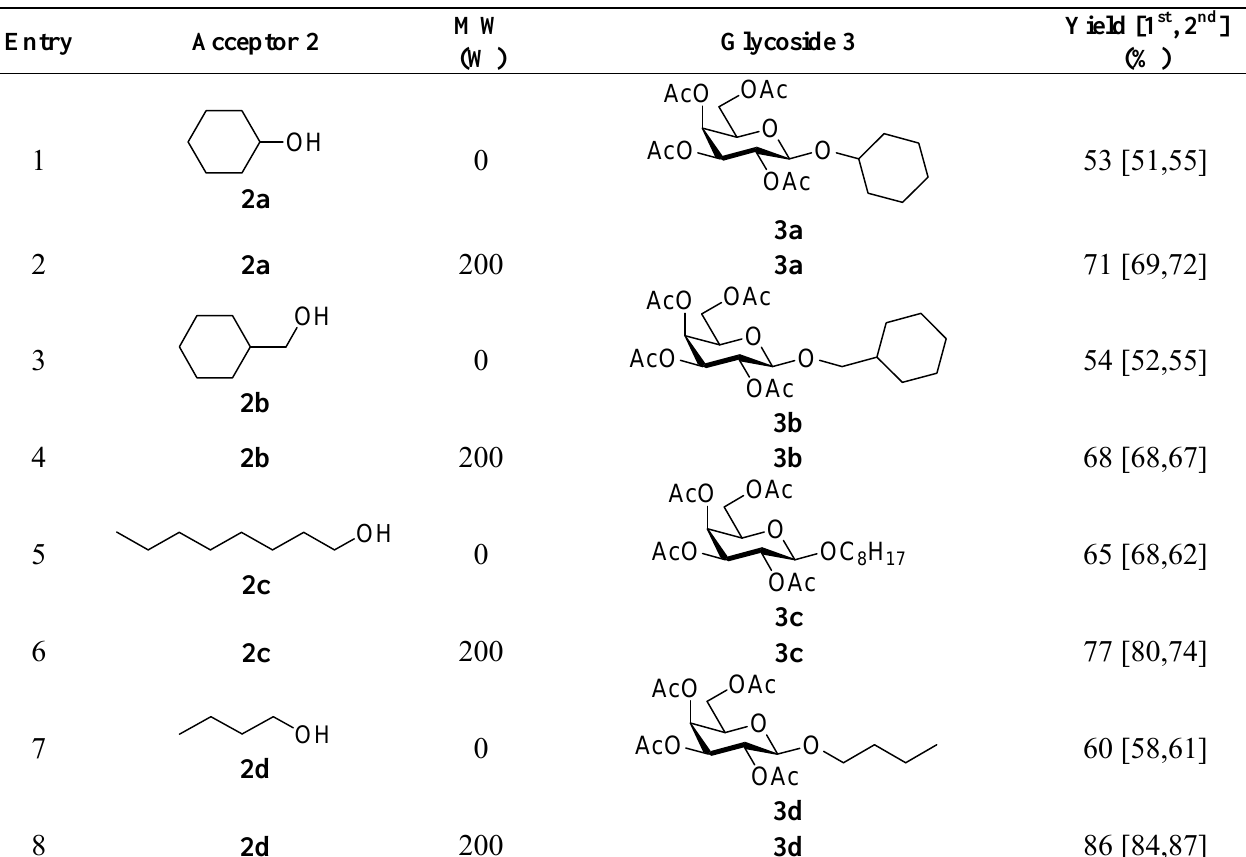
Table 1. Glycosylation of 1 and aliphatic glycosyl acceptors 2a - d promoted by ZrO in scCO with or without MW 2